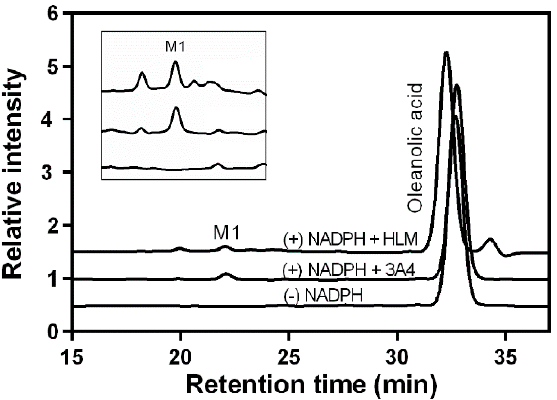
Figure 2. HPLC chromatograms of OA and its metabolites produced by human liver microsomes (HLMs). HPLC analyses of oxidation of OA by HLMs and CYP3A4. Peaks were identified by comparing the retention times of metabolite (M1): 4-epi-hederagenin ( t R = 22.4 min) and substrate OA ( t R = 32.3 min).